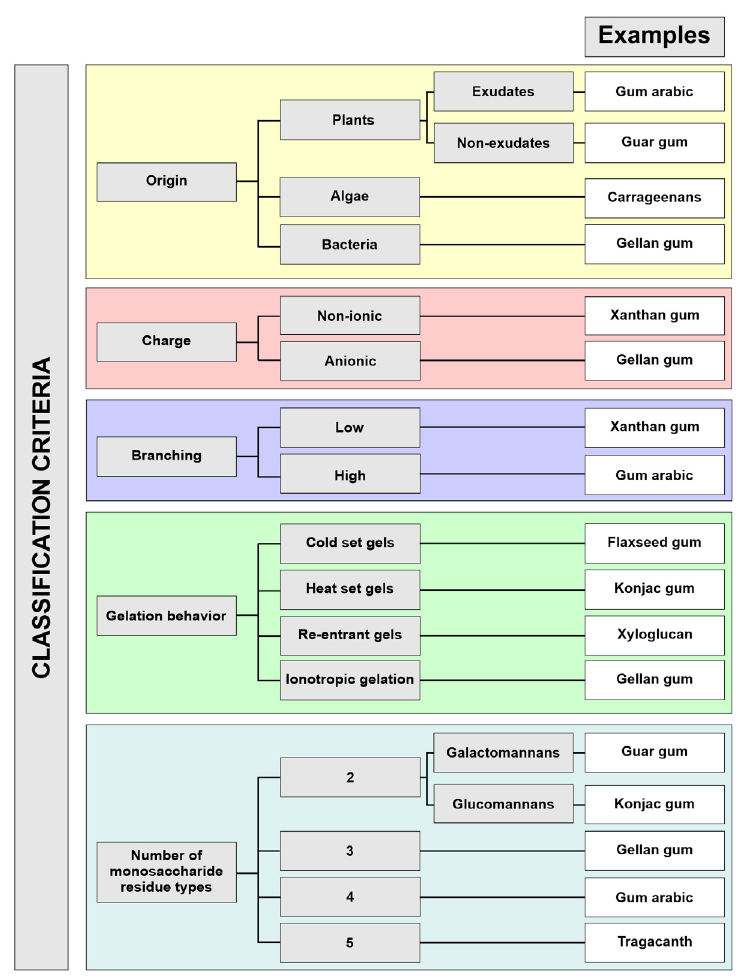
Figure 1. Natural gum classification according to different criteria